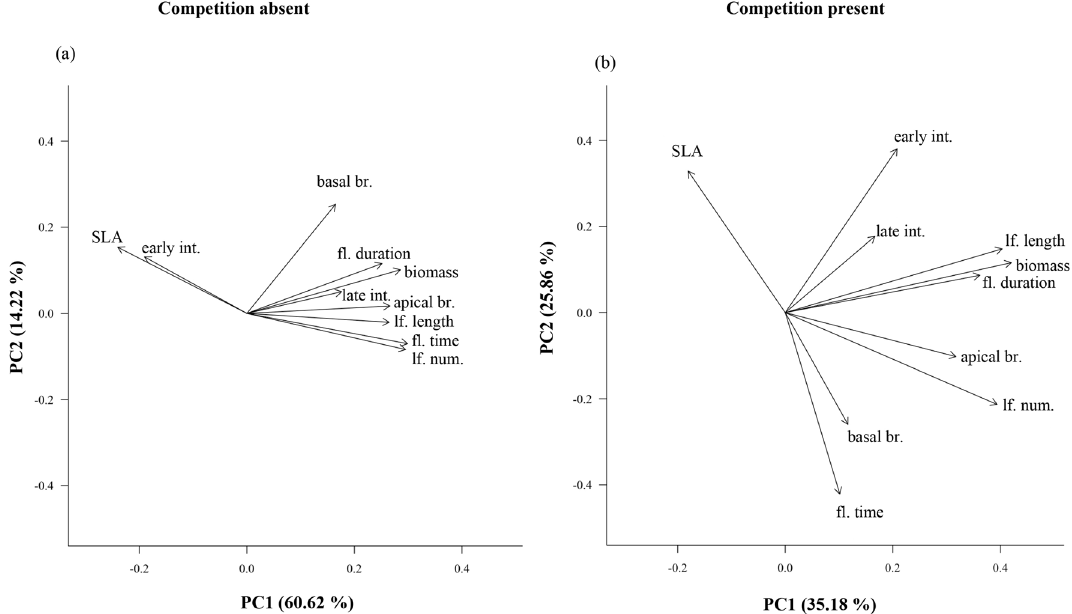
Figure 3. Principal components analysis output, showing relationships among our nine focal traits plus biomass for 35 genotypes of Arabidopsis thaliana grown without competition ( a ) and with competition ( b ). Each arrow represents the loading values for a given trait on principal components axis 1 (PC1) and axis 2 (PC2). Abbreviations are as follows: fl. time, flowering time; fl. duration, flowering duration; lf. num., number of rosette leaves; lf. length, longest rosette leaf length; SLA, specific leaf area; biomass, aboveground biomass; basal br., number of basal branches; apical br., number of apical branches; early int., early internode length; late int., late internode length.